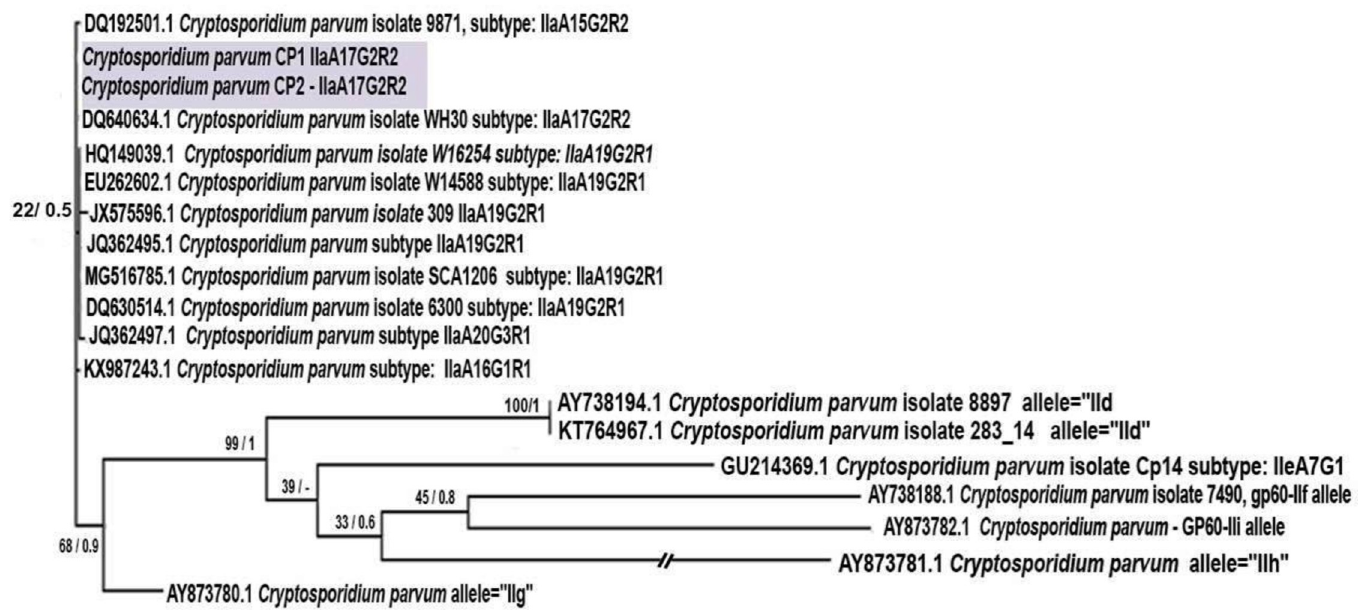
Fig 3. Maximum Likelihood (ML) tree of Cryptosporidium parvum based on GP60 partial gene using sequences obtained in the study and retrieved from Genbank. The first number associated with each node represents the ML bootstrap value followed by the Bayesian posterior probabilities. The blue rectangle represents C . parvum positive samples from this